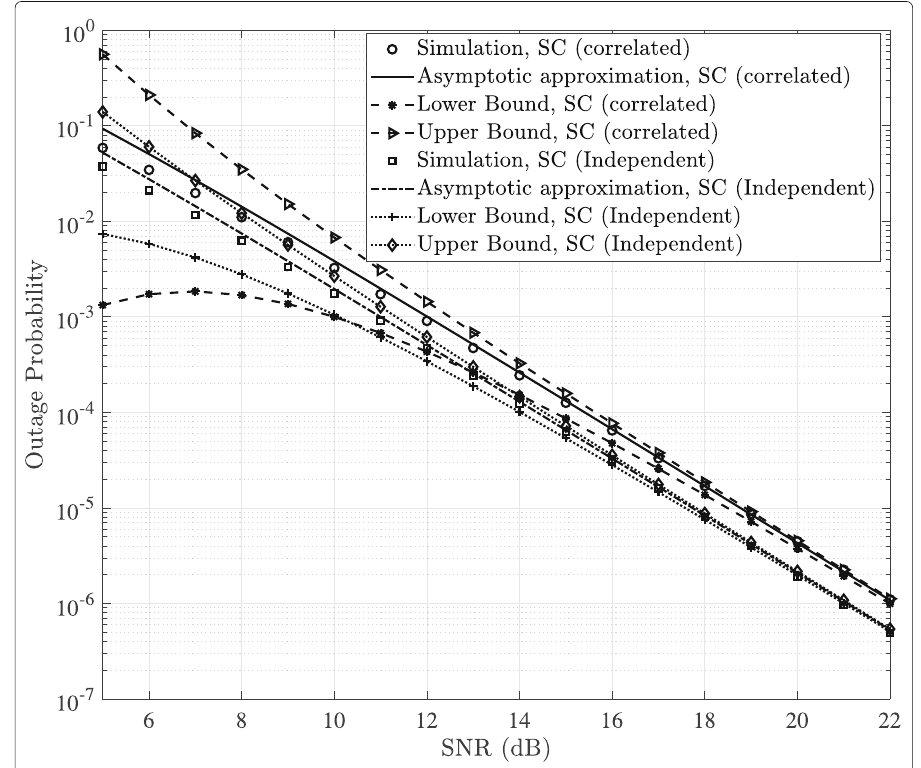
Fig. 3 OP curves for the asymptotic approximation, lower bound, and upper bound for SC over correlated and independent BX fading channels. The number of branches is N = 2, the fading parameter is m = 1.5, and (cid:12) C 1 , 0 2 × 2 , 0 2 × 2 ; 0 2 × 2 , C 2 , 0 2 × 2 ; 0 2 × 2 , 0 2 × 2 , C 3 the correlation structure is C b =